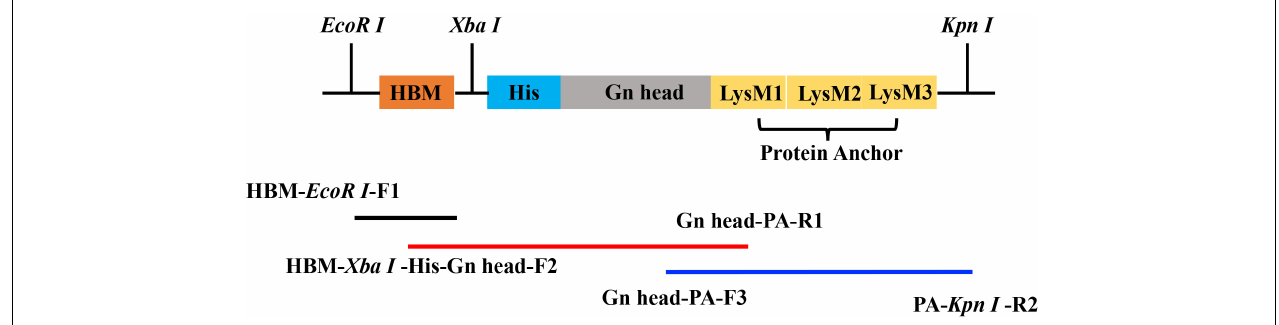
FIGURE 1 | Schematic representation of the plasmid. The primers in Table 1 were used to amplify the HBM-Gn head-PA fragment according to the